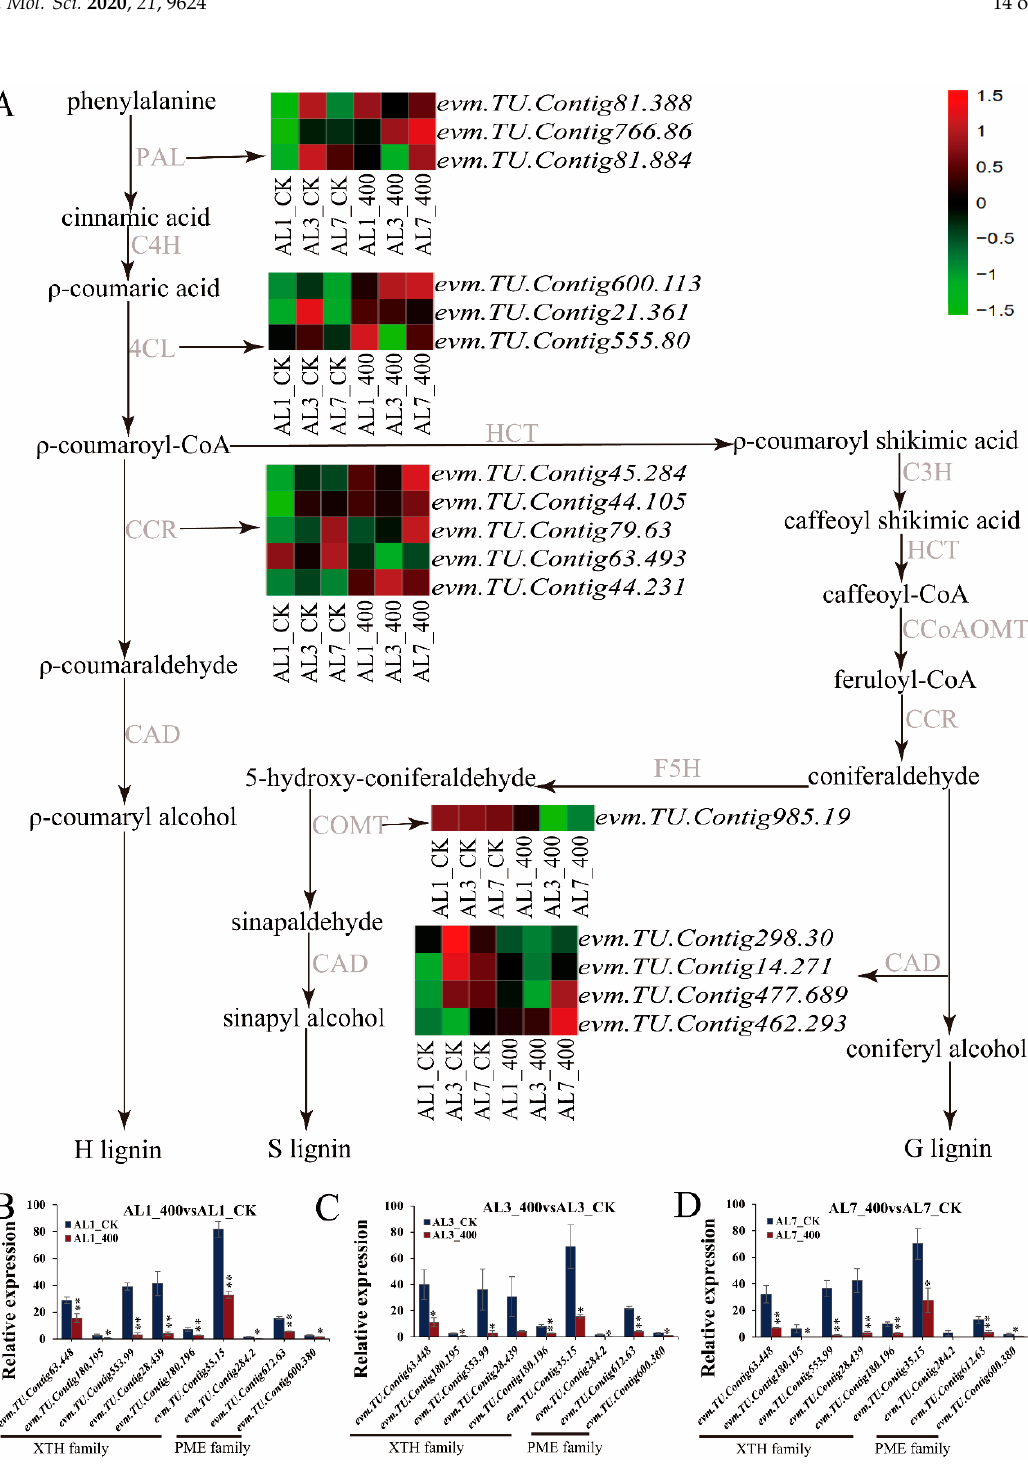
Figure 9. Expression of cell wall-related genes induced by aluminum stress. ( A ) Enrichment of DEGs in the phenylalanine pathway. ( B–D ) XTH/PME family DEGs relative expression. FDR < 0.05, |log 2 (FoldChange)| > 1. The * above the column chart showed that the electrical conductivity changed significantly between the two samples (* p < 0.05, ** p < 0.01).